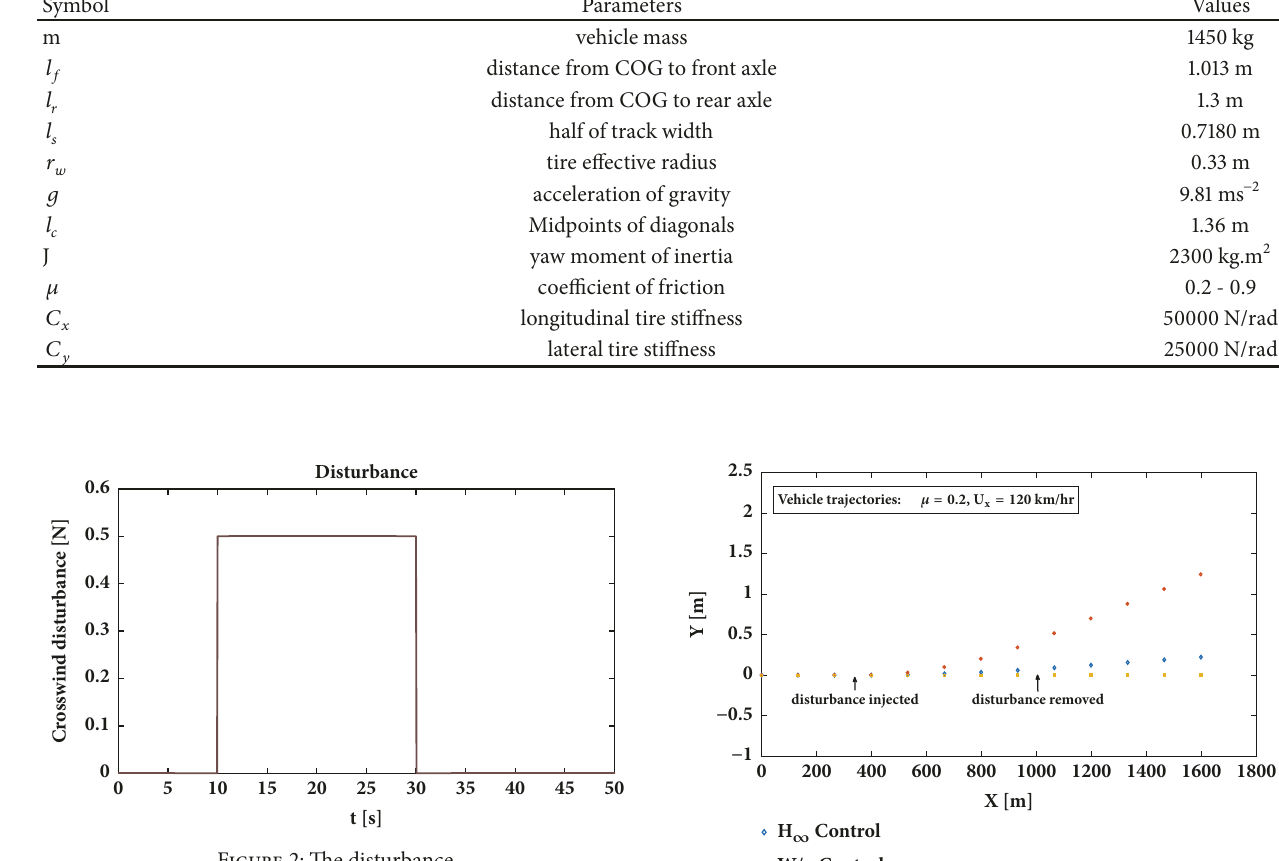
Figure 2: The disturbance.